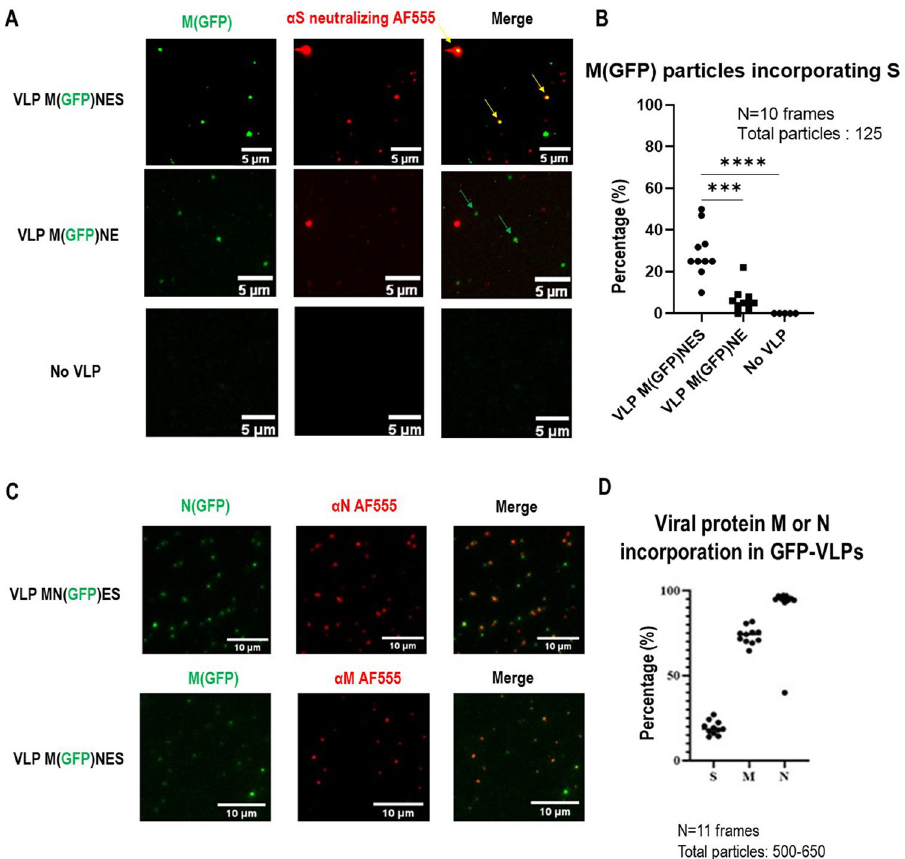
Figure 4. Evaluation of the incorporation of the Spike S, N and M in fluorescent SARS-CoV-2 VLPs using immuno-spotting coupled to TIRF-Microscopy. ( A ) TIRF images of M(GFP)NES VLPs, M(GFP)NE VLPs and control. An anti-S antibody coupled to a AF555 secondary antibody was used for S immunolabeling. Yellow arrows show the anti-S antibody-AF555 bound to VLPs-(GFP). Green arrows show VLPs-(GFP). Red arrows show antibody-labeled VLPs. The scale bar is 5 µm. ( B ) Percentage of S incorporation in M(GFP)NES versus M(GFP)NE and the control (no VLP). For each condition, 125 fluorescent particles were counted over 10 images (frames). One dot in the graph represents the % of S incorporation in the fluorescent VLP(M-GFP), i.e. % of colocalization in each frame. The t-test was calculated and the p-value between VLP M(GFP)NES and VLP M(GFP)NE is 0.0001 and p-value between VLP M(GFP)NES and No VLP is < 0.0001. ( C ) Images of SARS- CoV-2 M(GFP)NES and MN(GFP)ES VLPs as revealed by immuno-spotting coupled to TIRF-M, showing N or M incorporation in the MN(GFP)ES or M(GFP)NES VLP respectively with an anti-N or anti-M antibody coupled with an Alexa555 labeled secondary antibody, as indicated. The scale bar is 10 µm. ( D ) Quantification of the incorporation (%) of S, M or N on respective GFP-VLPs. N = 2, 11 images per sample and the number of particles counted was between 500 and 650 for each